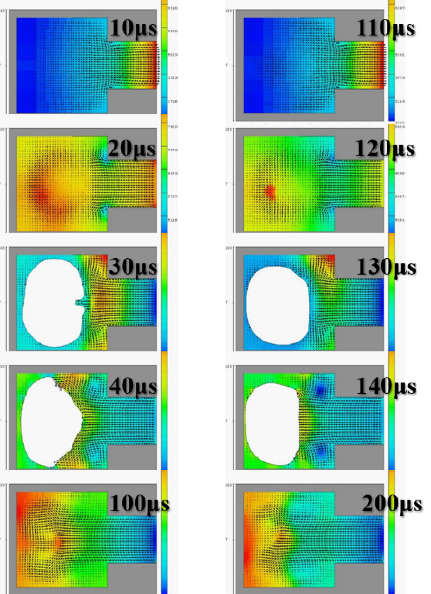
Figure 5. Calculate and simulate water in a single-channel jet cavity with a nozzle diameter of 60 µ m and a thickness of 50 µ m, with an operating frequency of 10 KHz, in the XZ two-dimensional cross-sectional view, at 10, 20, 30, 40, 100, 110, 120, 130, 140 and 200 µ s injection situation.